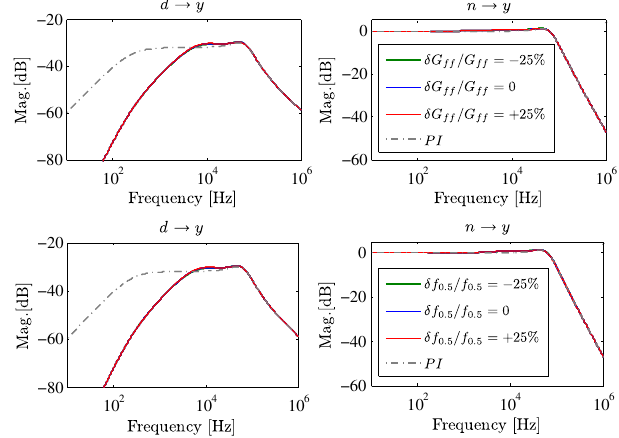
FIG. 9. Closed-loop transfer functions from d and n to y in the PI þ DOB control (assuming δω ¼ 0 and δθ ¼ 0 ). The figure shows the matched and mismatched cases, as well as the PI individual control case (indicated by the grey dash-dotted curve). From top to bottom: mismatch in plant gain ( G ), mismatch in ff cavity bandwidth ( f 0 ). . 5